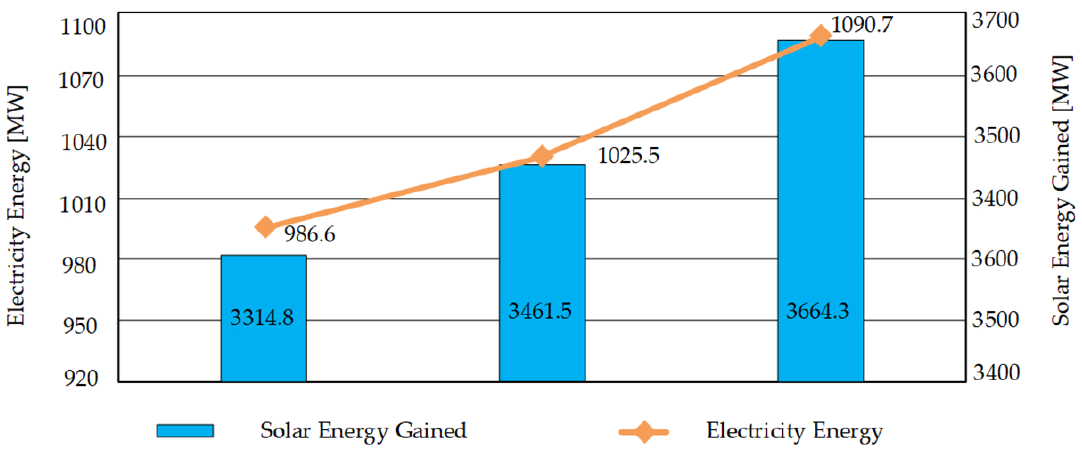
Figure 14. The annual collector energy gained and electric energy for selected sites.